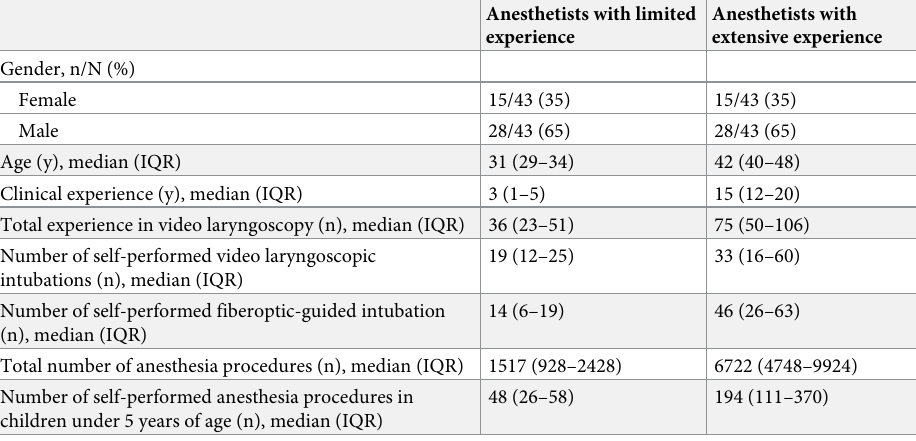
Table 1. Participant characteristics and documented previous